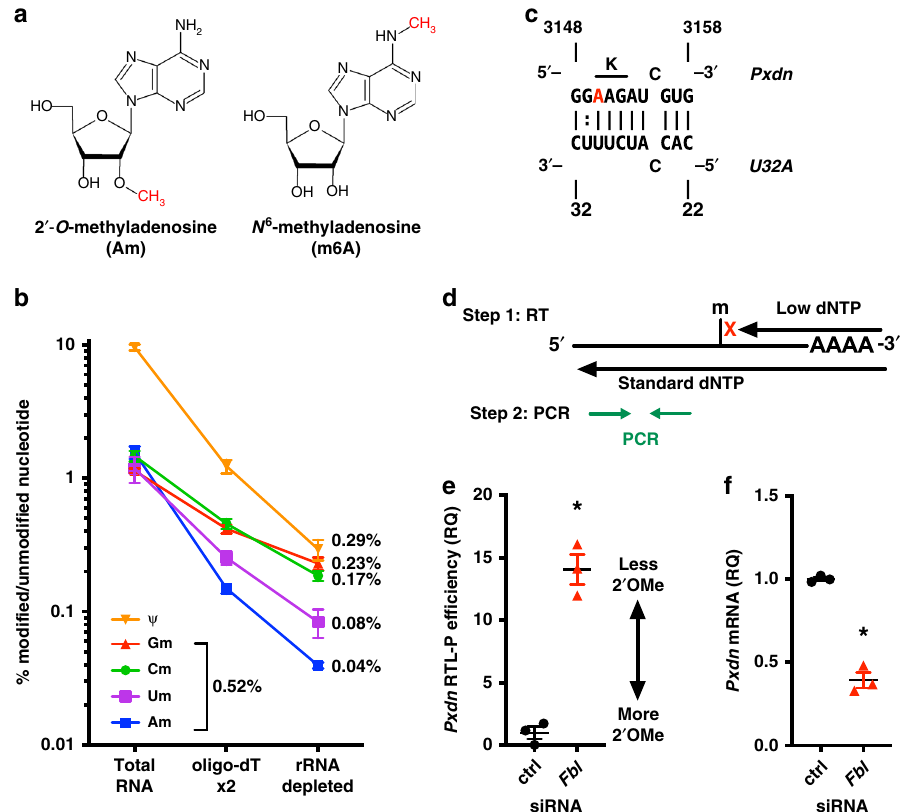
Fig. 1 2 ′ - O -methylation on Pxdn mRNA requires fi brillarin. a 2 ′ - O -methylation (Nm) can occur in combination with any base. Nucleoside Am is shown, compared to base-modi fi ed m6A. b UPLC-MS/MS quanti fi cation of modi fi ed nucleosides on total RNA, mRNA after two rounds of oligo-dT selection, and mRNA further puri fi ed by rRNA depletion. c Predicted interaction between human snoRNA U32A ( U32A ) and peroxidasin ( Pxdn ). A3150 is the predicted Nm target (red), which is the fi rst position of a lysine codon (K). d Illustration of RTL-P method. The amount of qPCR product from the low dNTP reactions of two different samples can be compared to establish the relative “ RTL-P ef fi ciency (RQ) ” . RQ = relative quantity. See Methods for detail. e – f Fbl knockdown (KD) in HeLa cells, vs. negative control (ctrl) using siRNA for 48 h. n = 3 independent experiments, SEM error bars, * p < 0.05 by unpaired t -test. e Fbl KD leads to loss of Nm on Pxdn mRNA ( p = 0.0005). f Fbl KD reduces Pxdn mRNA levels, normalized to Rplp0 control transcript ( p = 0.0002)